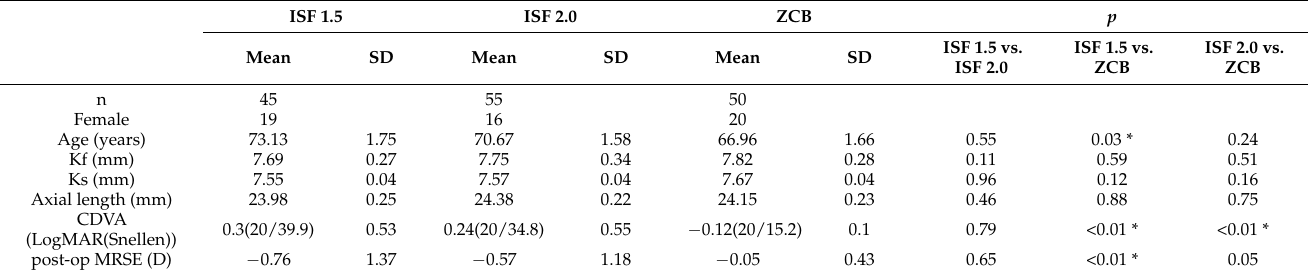
Table 1. Clinical features of the study eyes.